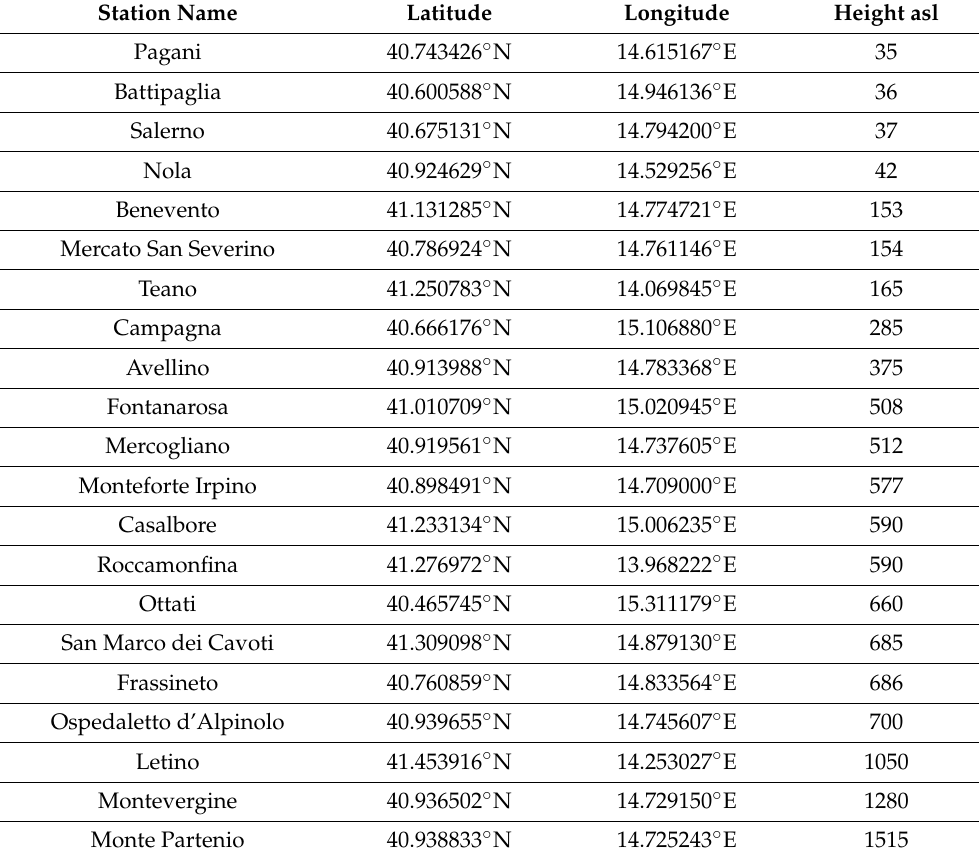
Table 2. List of Automatic Weather Stations (AWS) adopted in the framework of the CARMEN project. For each station, the latitude (in degrees), the longitude (in degrees) and the height above sea level (in m) are shown. The AWS belong to institutional and local meteorological networks and provide temperature measurements with a time resolution of 10